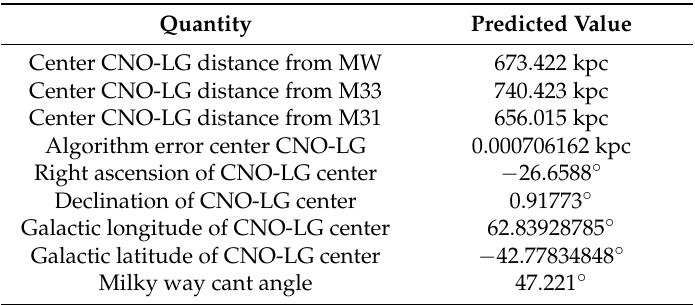
Table 7. Monte Carlo-derived CNO Local Group parameters.